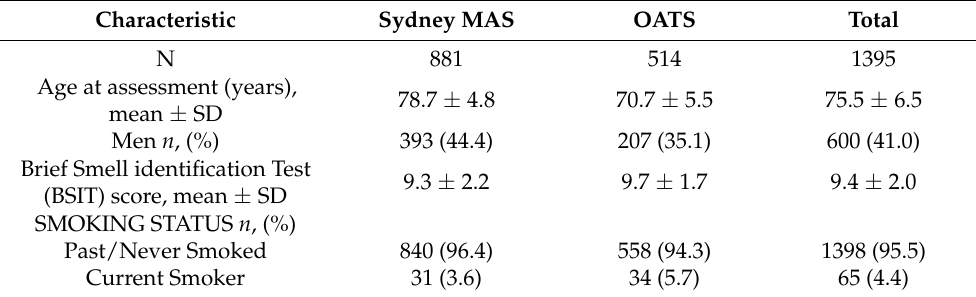
Table 1. Descriptive statistics for Sydney MAS and OATS participants with both genotyping and BSIT data.